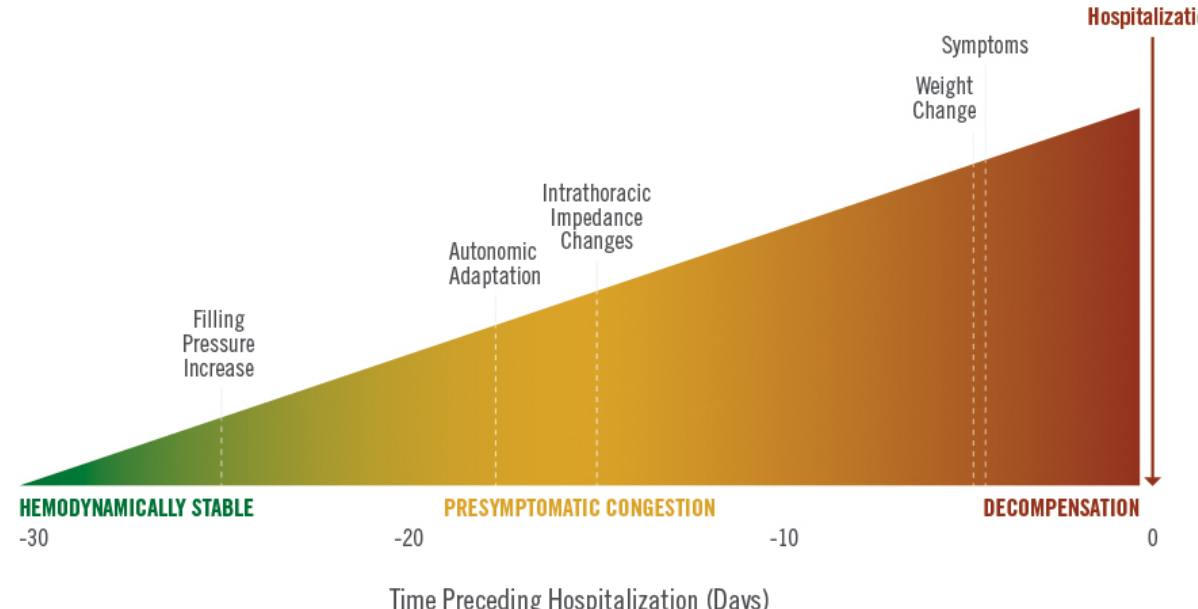
Figure 2. The effect of repeated heart failure hospitalizations on patient survival. Reprinted from American Heart Journal, Volume 154, Issue 2, Setoguchi et al., Repeated hospitalizations predict mortality in the community population with heart failure, Pages 260–266, Copyright 2007, with permission from Elsevier [4].